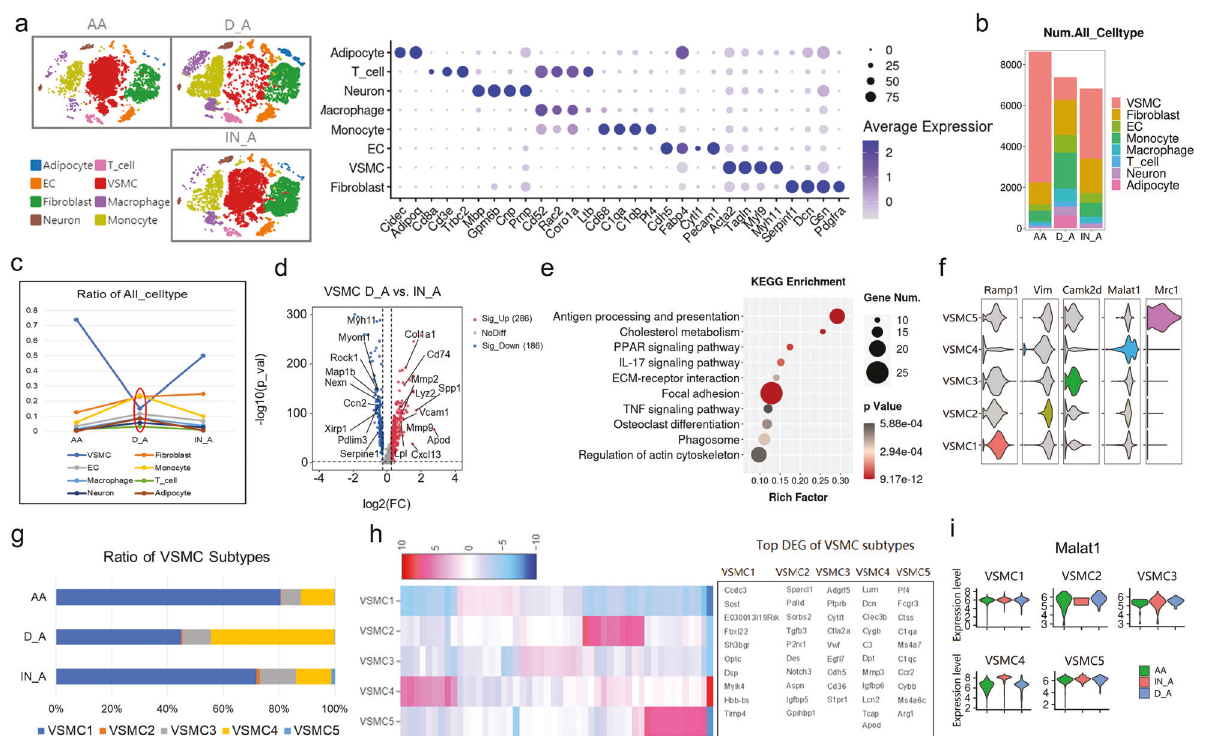
Fig. 8 Single-cell analysis of AngII-induced AAA with DMSO or inhibitor. a T-SNE plot showing the clustering of 22, 975 cells isolated from aortic tissues of three groups by split view. The dot plot showed that the average scaled expression levels of marker genes were consistent with the identi fi cation of the fi rst fi ve samples. AA, healthy abdominal aorta; D_A, AngII-induced AAA with DMSO; IN_A, AngII-induced AAA with inhibitor. b The bar chart showed the number of major cell types across the three groups. c The line chart showed the proportion of major cell types across the three groups. The ratio of VSMCs and immune cells changed the most. d The fold change of all genes with a signi fi cant difference in VSMCs between D_A and IN_A groups was presented by the volcano plot. e KEGG analysis of downregulated genes in IN_A vs. D_A group. f Identi fi cation of VSMC subtypes based on the previous marker genes in the fi rst fi ve samples. g The bar chart showed the ratio of fi ve VSMC subtypes across three groups, in which VSMC 1 and VSMC 4 changed obviously. h In addition to the existing marker genes, the top differentially expressed genes (DEGs) in each subtype were shown by the heatmap. i The expression level changes of Malat1 in each subtype across three groups are shown by the violin plot, in which the Malat1 expression level of VSMC 4 increased in the D_A